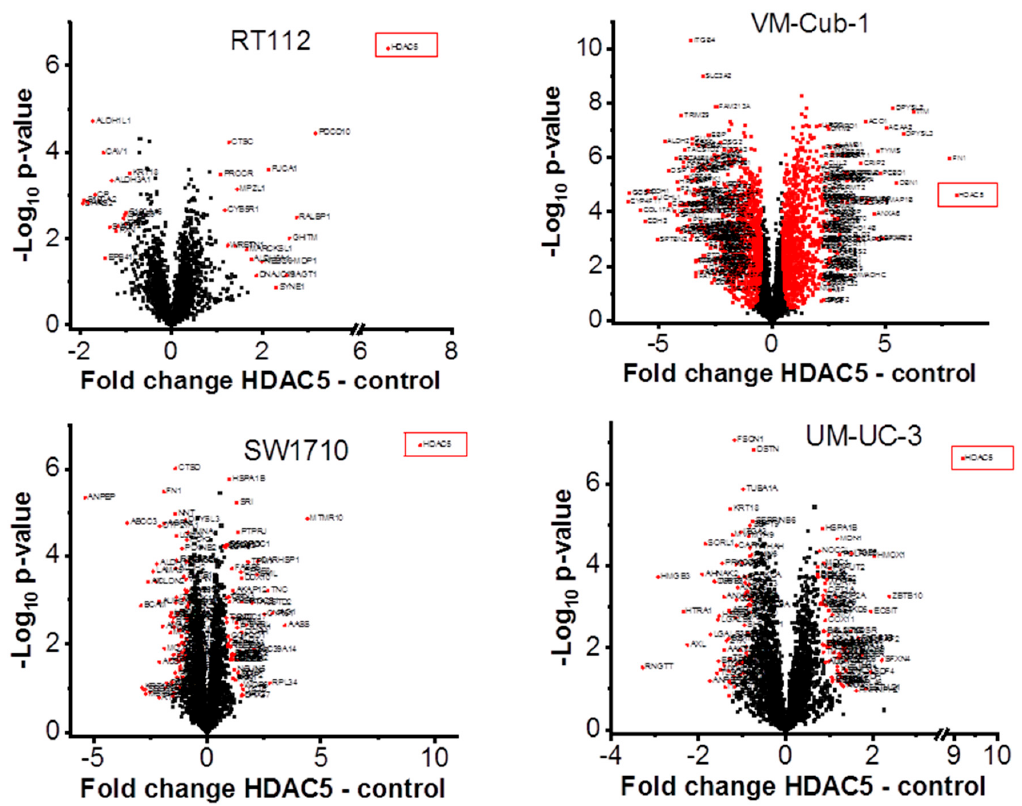
Figure 6. Volcano plot analysis of proteomic changes in UC cell lines transduced with vector only or HDAC5. Significantly differentially abundant proteins in HDAC5 overexpressing cells are marked by red squares. Gene names for VM-Cub-1 are shown only for proteins with at last a two-fold change. The indicated fold changes “HDAC5—control” represent the difference of mean log2 transformed intensities of HDAC5 and vector samples.